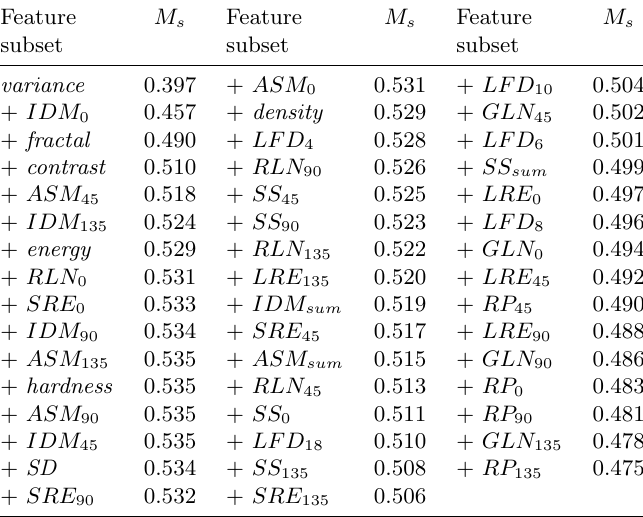
Table 2. Merit scores ( M s ) of the subset of features. The size of feature subset increases from top-left to bottom-right by adding one feature after another to an existing feature subset. The plus sign (+) before a feature indicates that the feature is added to an existing